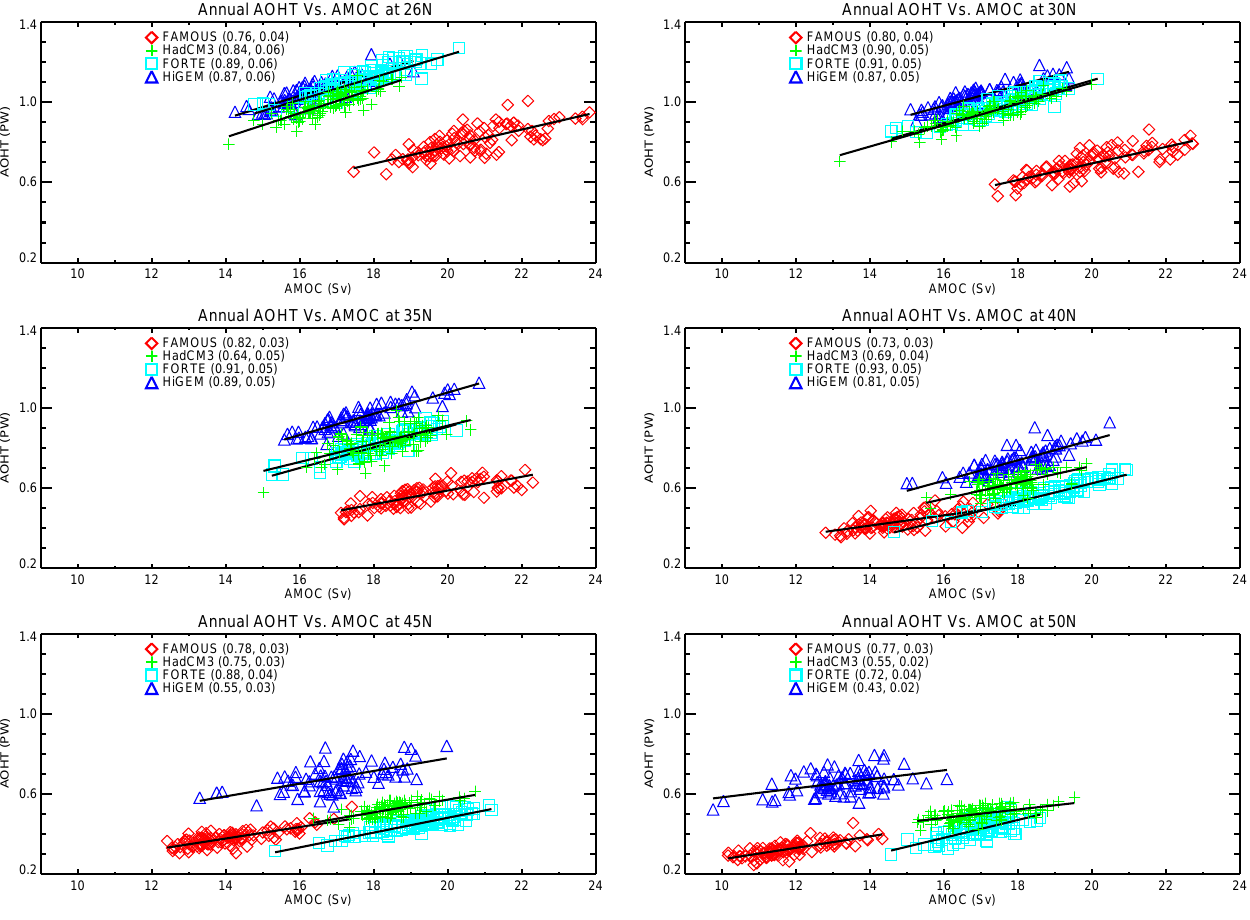
Fig. 10. Scatter plot of annual-mean ocean meridional overturning transport, T over (Sv) and ocean meridional heat transport (PW) at various latitudes in the North Atlantic in different models. The correlation coefficients and slopes of the regression are given in brackets. RAPID-models do not have a similar zonal profile, in general a good degree of temporal correlation is found between them at all latitudes from 15 ◦ N to 45 ◦ N (Fig. 10, 8b, Table 1 for 26 ◦ N). Towards higher latitudes, the contribution due to the overturning decreases. The slopes of the regression are fairly similar between 26–45 ◦ N, indicating the positive volume- heat transport relationship at these latitudes. However, since the AMOC at 26 ◦ N and 50 ◦ N are not strongly correlated (Sect. 5), we expect that AOHT at 50 ◦ N, in the latitudes of the northern Europe, is not strongly correlated with the AMOC at 26 ◦ N. Indeed this is the case in HadCM3, FA- MOUS, FORTE, CHIME and HiGEM (Table 1). The